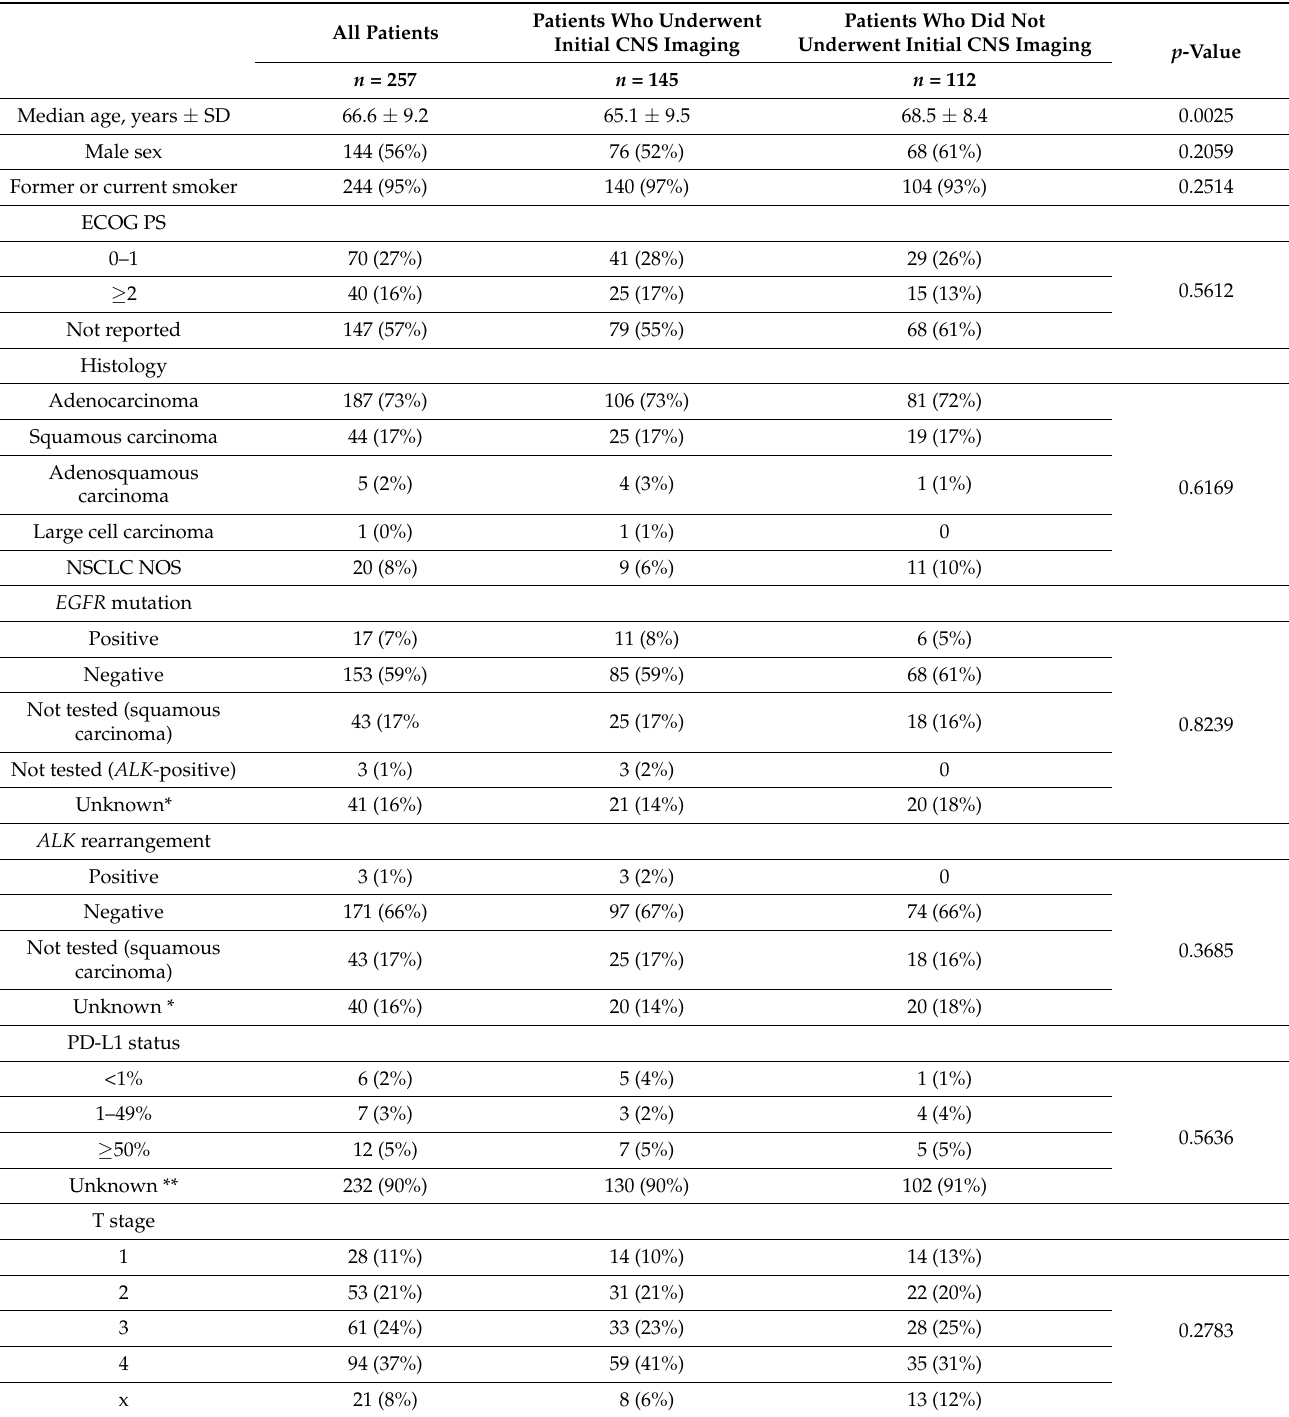
Table 1. Patient